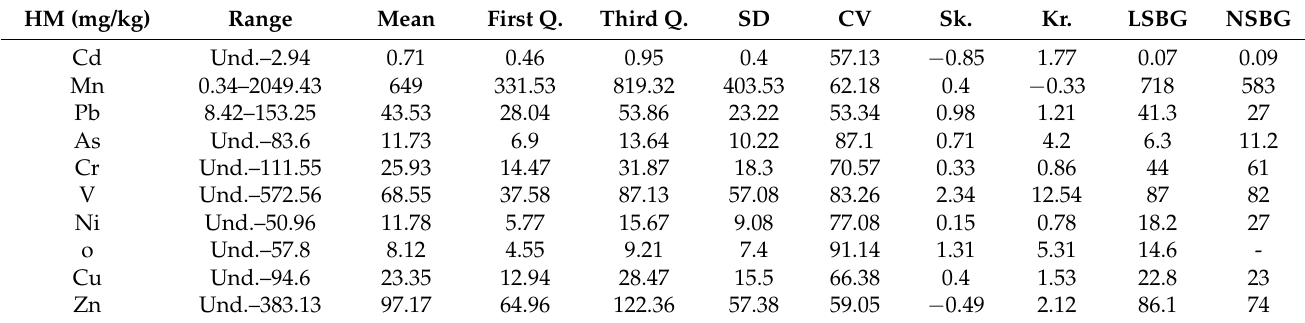
Table 1. Descriptive statistics of the soil heavy metal(loid) concentrations in Fuzhou city (mg/kg dry weight). HM